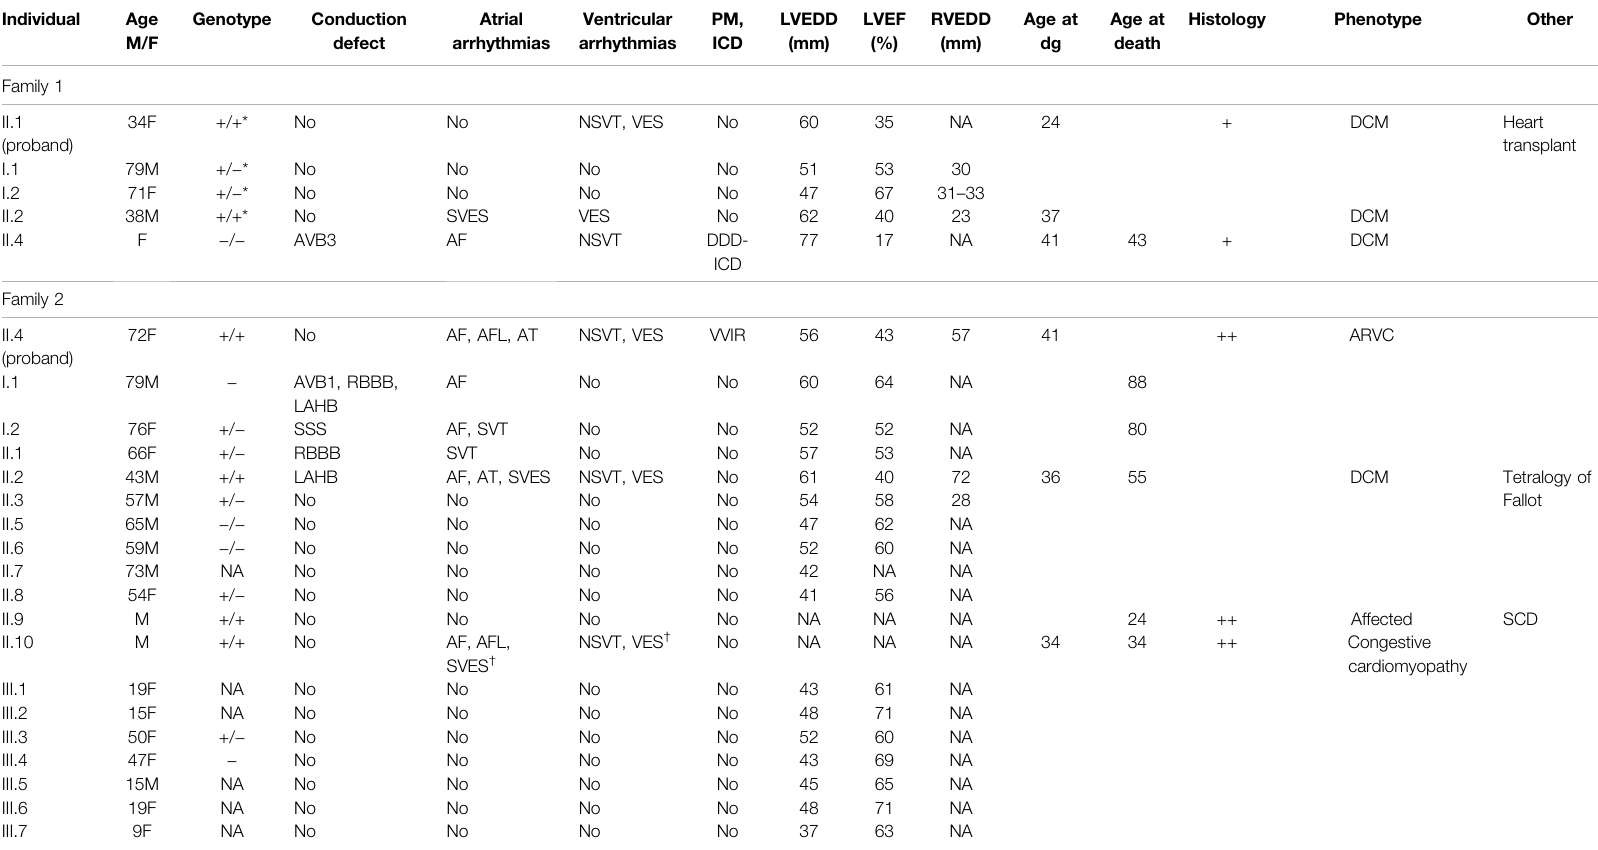
TABLE 1 | The main clinical features of the probands and their relatives. Probands are marked in bold. Symbols and abbreviations: Age (M/F) age and sex (M: male/F: female); Genotype: +/ + homozygous and +/ − heterozygousforthe GCOM1 c.1150 A > T,p.(Lys384*);+/+*homozygousand+/-*heterozygousforthe GCOM1 c.388C > T,p.(Arg130*), − / − wildtypeallele;NAnotavailable;AVB1andAVB3foratrioventricularblock 1and3,LAHBforleftanteriorhemiblock,RBBBforrightbundlebranchblock,SSSforsicksinussyndrome;Atrialarrhythmias – arrhythmiasofatrialorigin:SVESforsupraventricularextrasystoles > 100/24 h, † whenobserved in stress-test, AF for atrial fi brillation, AFL for atrial fl utter, AT for atrial tachycardia, SVT for supraventricular tachycardia; ventricular arrhythmias – arrhythmias of ventricular origin: VES for ventricular extrasystoles > 100/24 h, † when observed in stress-test, NSVT for non-sustained ventricular tachycardia; PM pacemaker, ICD implantable cardioverter-de fi brillator; LVEDD left ventricular end-diastolic diameter (millimeters); LVEF left ventricular ejectionfraction(%);RVEDDrightventricularend-diastolicdiameter(millimeters);Ageatdg – ageatthetimeofdiagnosisofcardiomyopathy;Histology:+ifendomyocardialbiopsywastaken,++iftheheartwasexamined post-mortem or after explantation; Phenotype – phenotype at diagnosis; DCM dilated cardiomyopathy; ARVC arrhythmogenic right ventricular cardiomyopathy; Other – other signi fi cant clinical features; SCD sudden cardiac